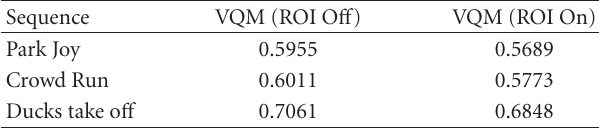
Table 4: Comparison of VQM results between enabled and disabled ROI for the Park Joy , Ducks take o ff , and Crowd Run video sequences. Sequence VQM (ROI O ff ) VQM (ROI On) Park Joy 0.5955 0.5689 0.6011